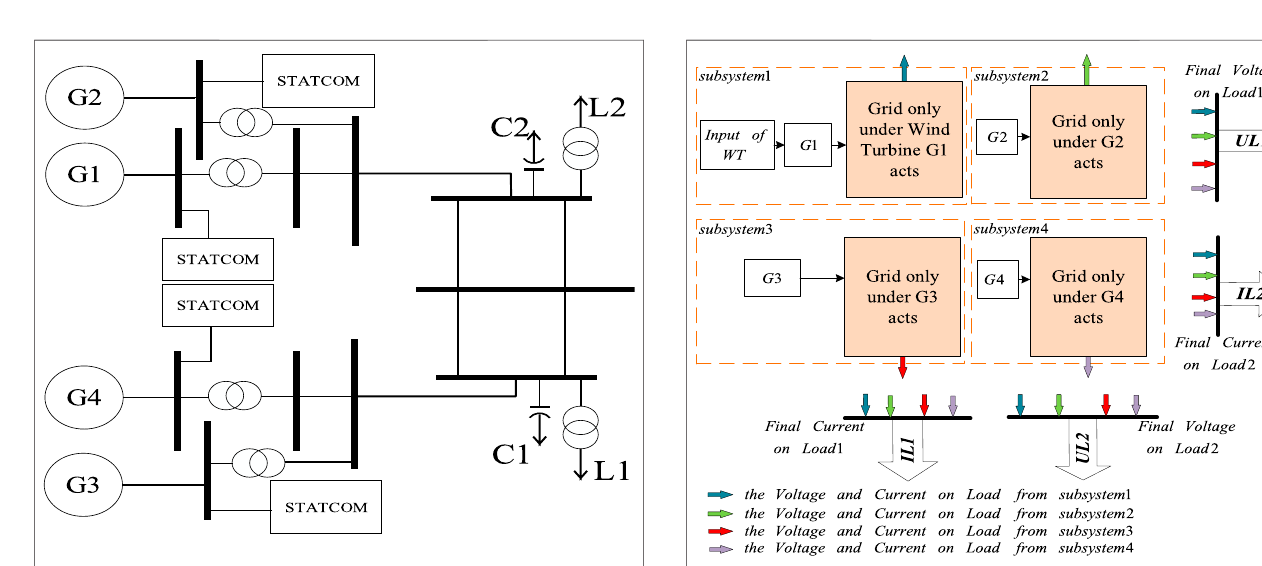
FIGURE 5 | Four-machine two-area wind power system.